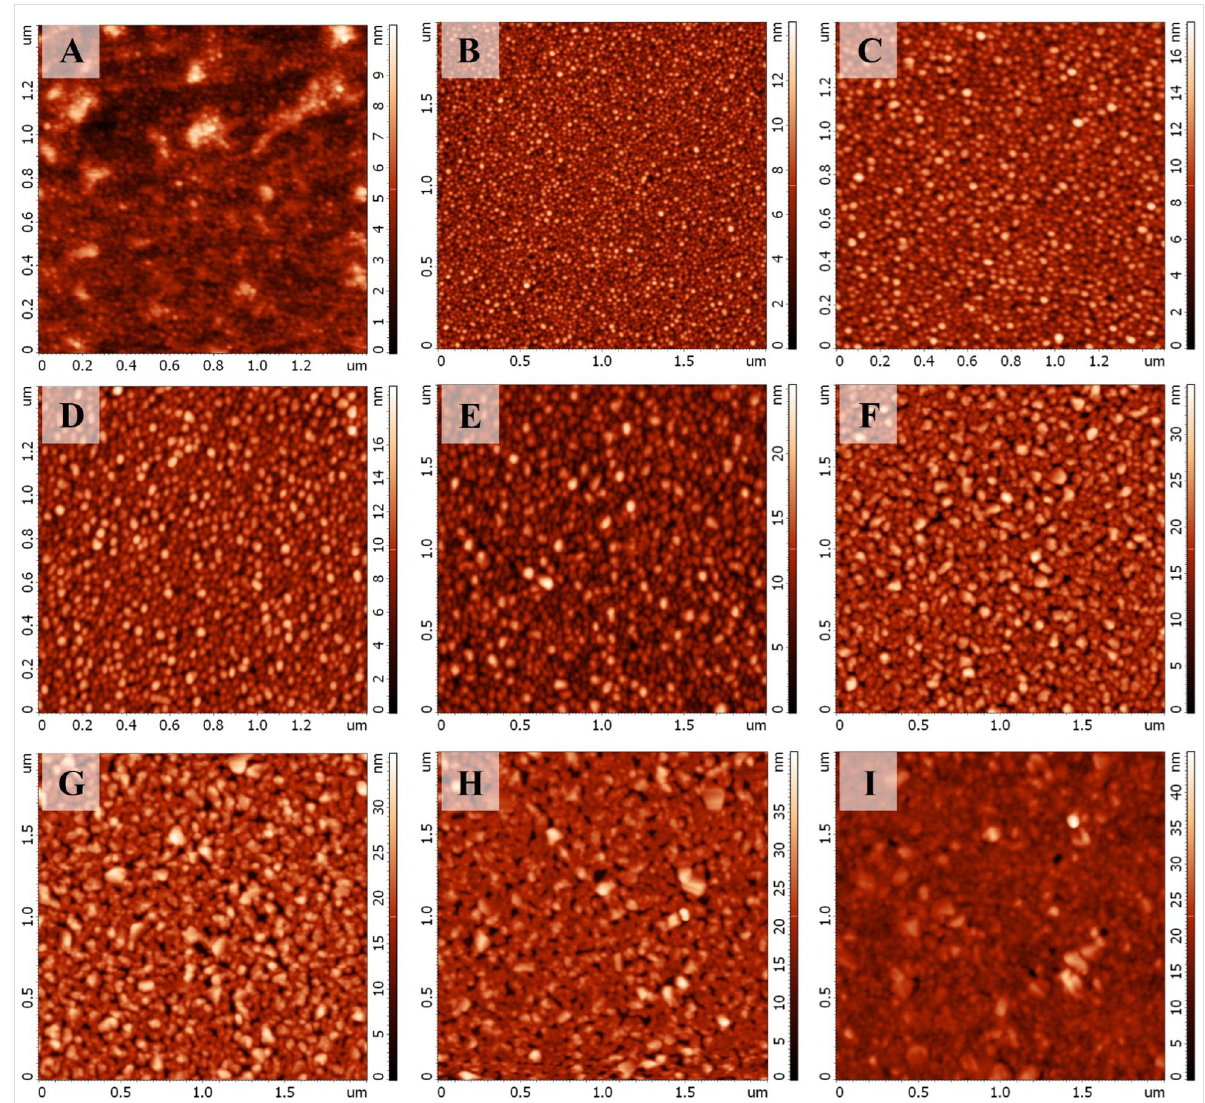
Figure 2: (A– I) AFM maps of SSFs with different Ag thickness. Samples A, C and D have a different scan area than the other samples.